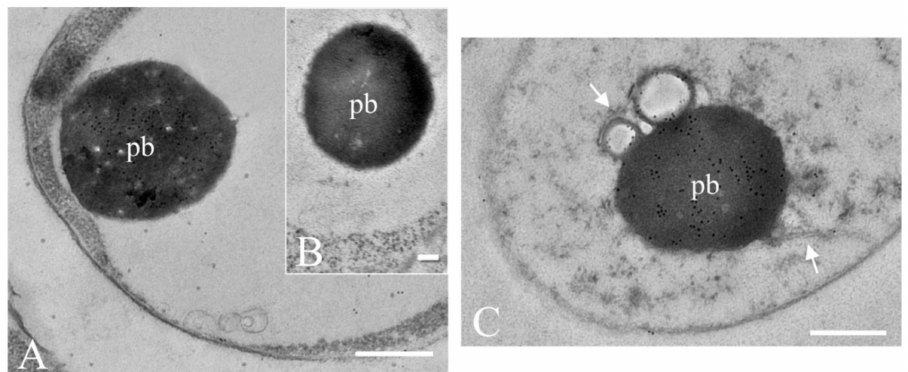
Figure 8. Immunogold labelling of ultrathin sections of A. aegerita with the rabbit antiserum against Ageritin showing the presence of numerous 10 nm gold particles within an electron dense protein-like body (pb) inside the vacuole of an hyphae ( A ). No gold particles are present in labelling control with a pre-immune serum ( B ). The protein body (pb) seems to be originated inside the ER ( C , arrows). Bars are 500 nm in ( A , C ) and 200 nm in ( B